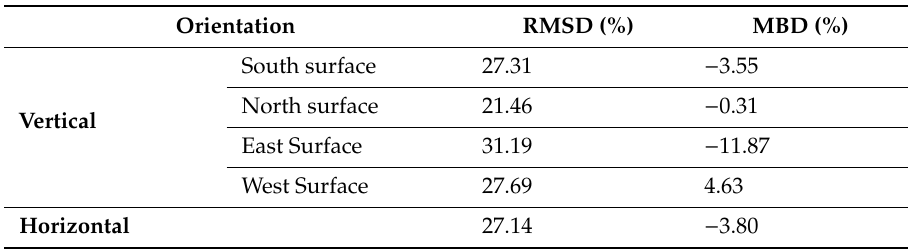
Table 5. RMSD and MBD calculated for the vertical di ff use illuminance, L dv , and the horizontal di ff use illuminance, L dh . The reference values of L dv were calculated from Equation (5). The reference values of L dh were measured in the experimental facility, described in Section